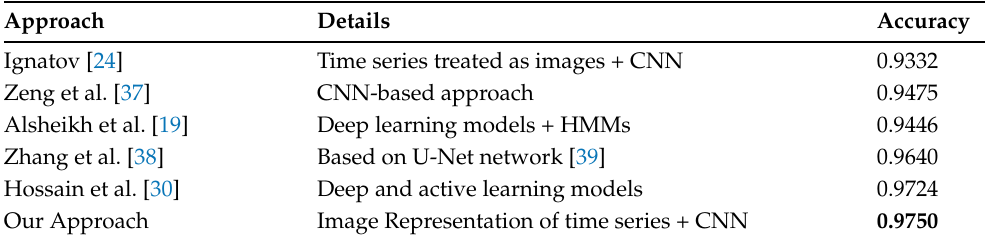
Table 2. Comparison considering WISDM dataset.